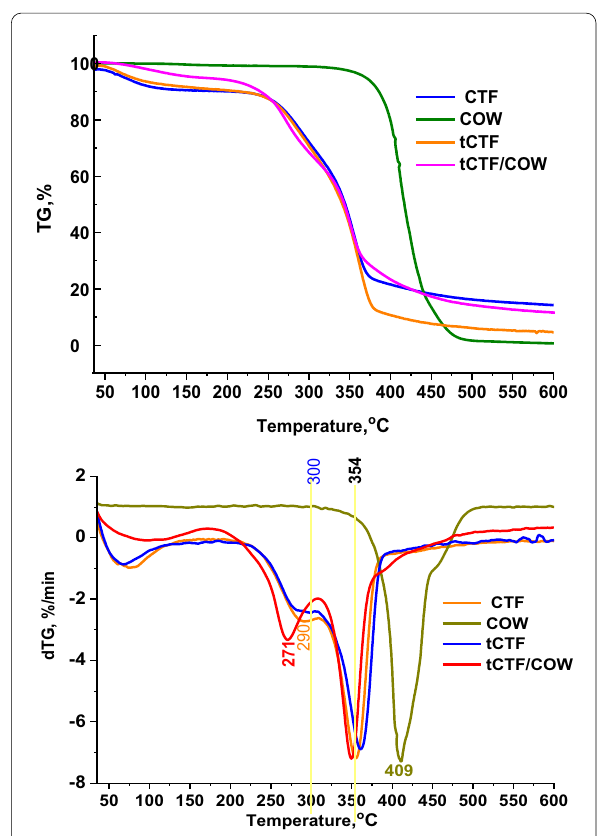
Fig. 3 Thermal analysis of samples (TGA (upper) and DTGA (lower))